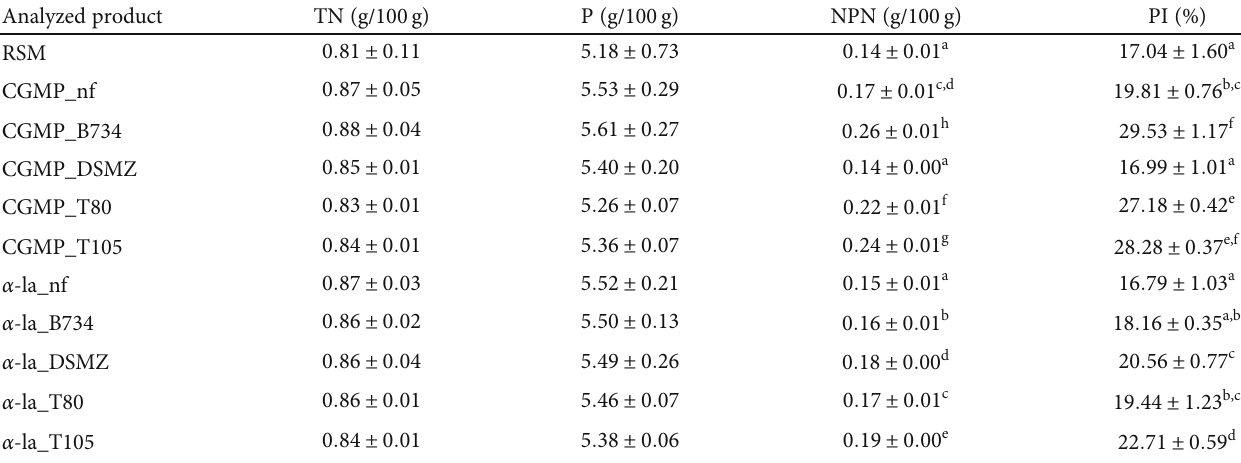
Table 4: Proteolysis index, protein, non-protein nitrogen, and total nitrogen contents in the obtained milk products. Analyzed